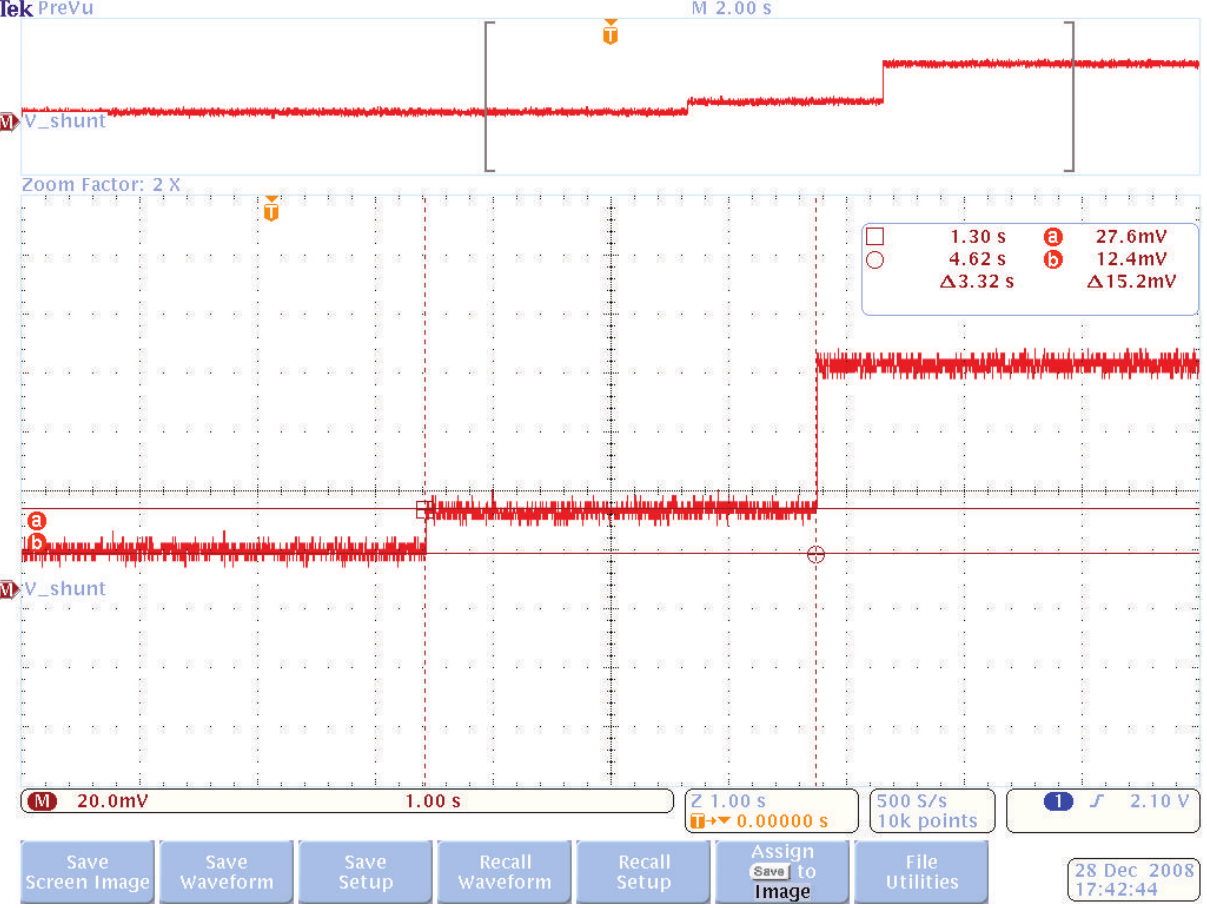
Figure 15: Power consumption for Virtex II Pro’s full reconfiguration. The Y axis is voltage measured at the shunt resistors during the reconfiguration process according to setup shown in Figure 7. This figure is an oscilloscope